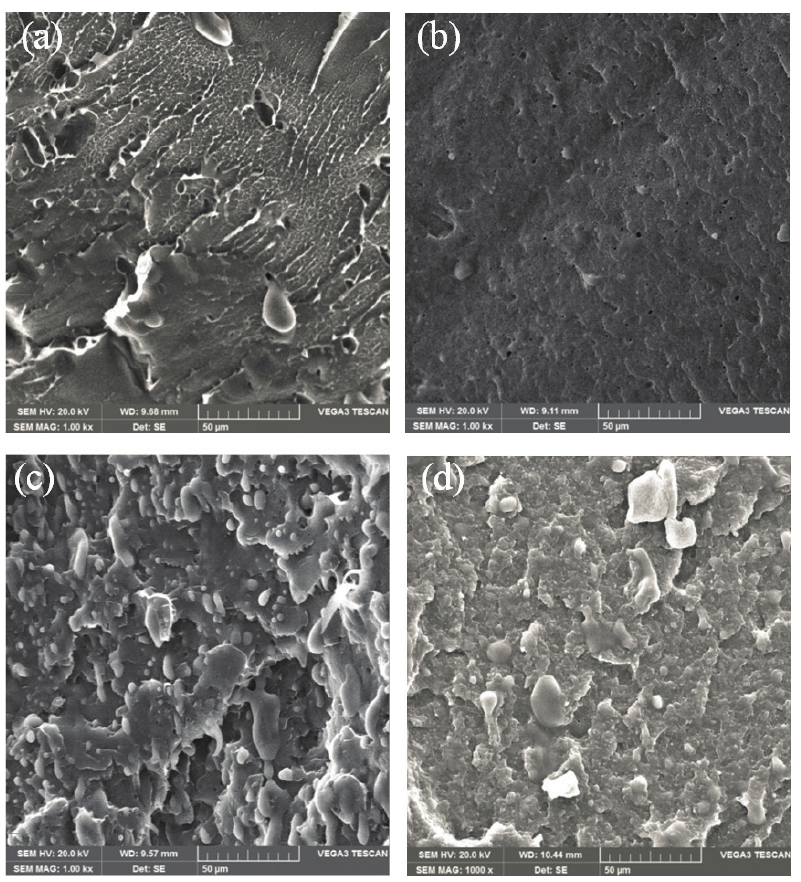
Fig. 10 – SEM micrographs of (a) LDPE/TPS20, (b) LDPE/TPS20/SEBS-g-MA, (c) LDPE/TPS50, (d)